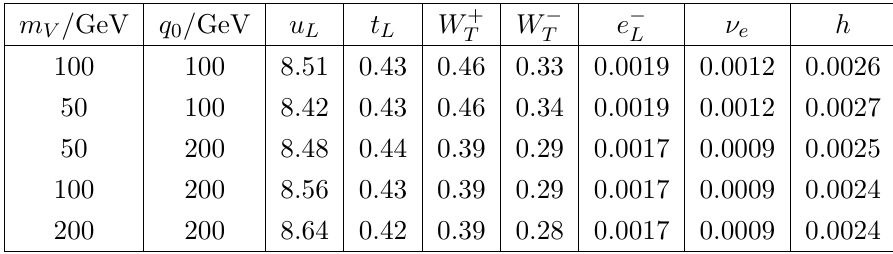
Table 2 . Momentum fractions (%) carried by various parton species at scale q = 10 TeV.